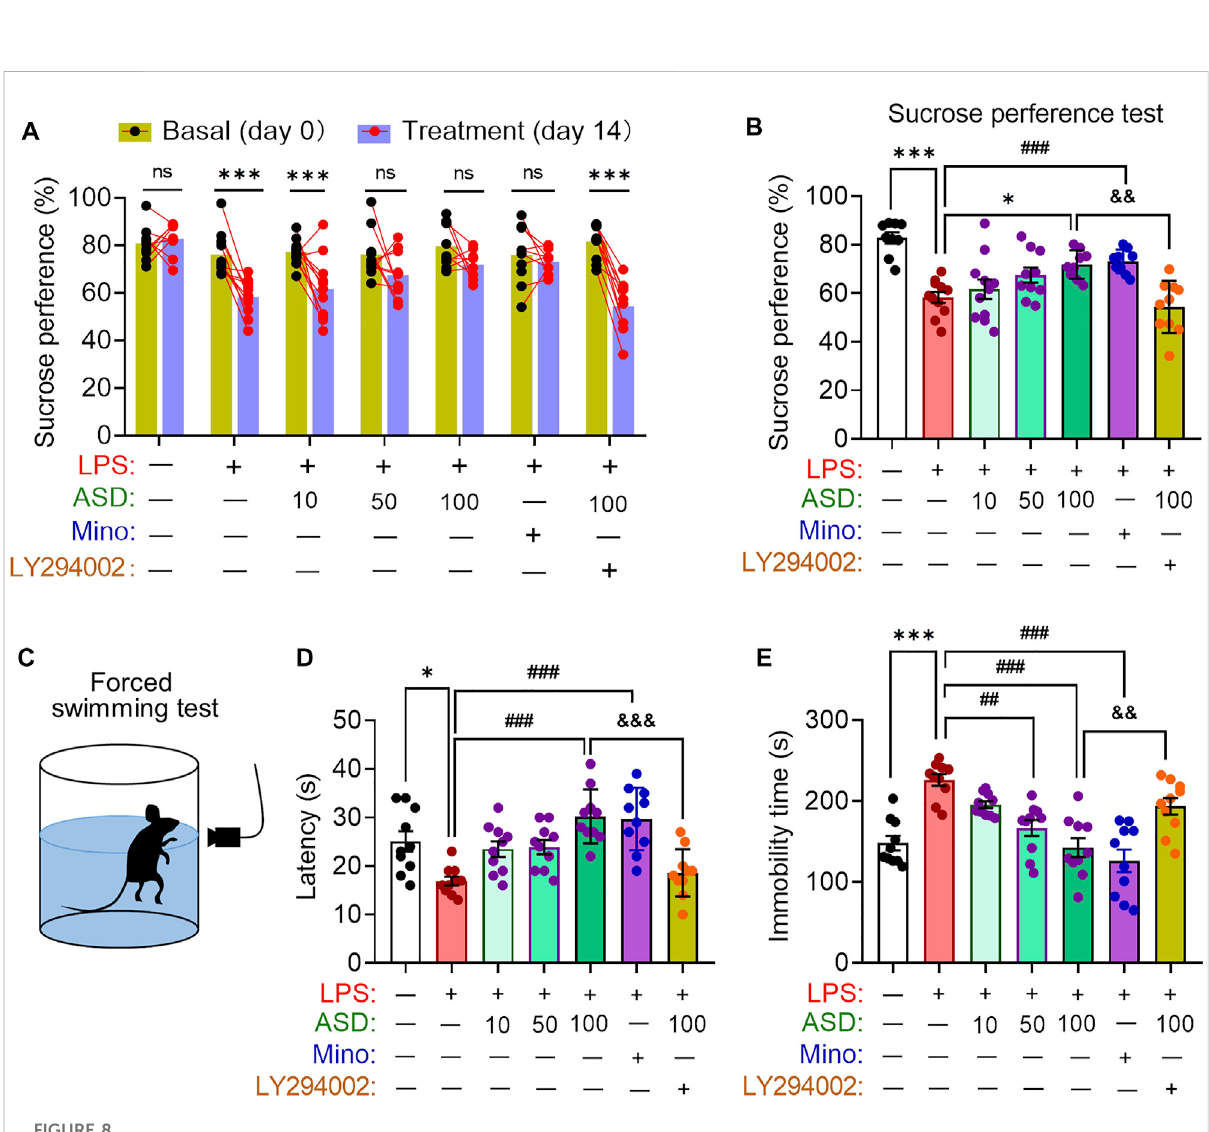
FIGURE 8 Effects of ASD on depressive-like behaviors of mice chronically exposed to LPS in the presence or absence of PI3K-Akt inhibitor. (A) , Changes in sucrose preference of individual saline-treated (Ctrl) or lipopolysaccharide (LPS)-treated mice, before treatment (day 0) and afterward (day 14). (B) , ChangesinsucrosepreferencefollowingtreatmentwithakebiasaponinD(ASD),minocycline(Mino)orPI3K-Aktinhibitor(LY294002)for14days. (C – E) , EffectsofASDonimmobilitytimeandlatencyintheforcedswimmingtest. Dataaremean± standarderrorofthemean(SEM)(n=8-11).